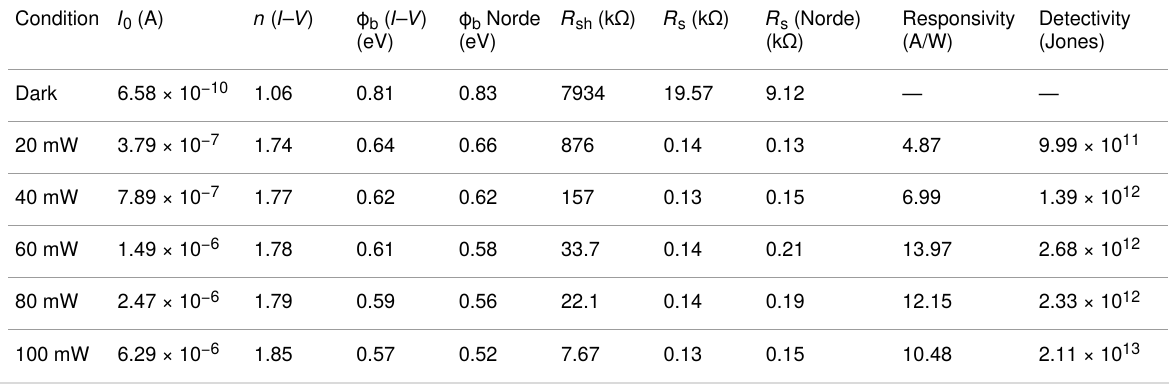
The responsivity and specific detectivity are other important pa- rameters of a photodiode or photodetector. While the respon- sivity represents the response to the incident light, the specific detectivity represents the inverse of the noise equivalent power [32]. Both responsivity and specific detectivity increased